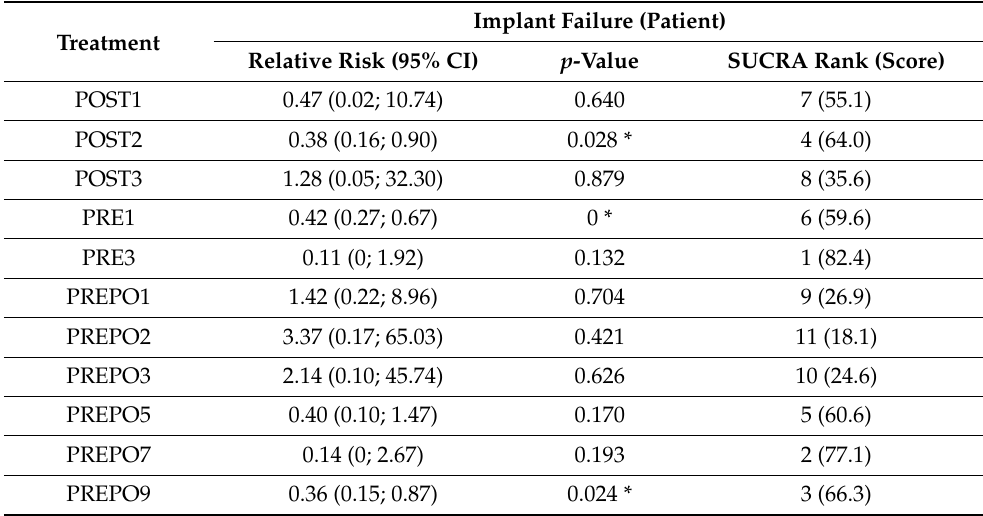
Table 2. Results of network meta-analysis: implant failure (per patient).